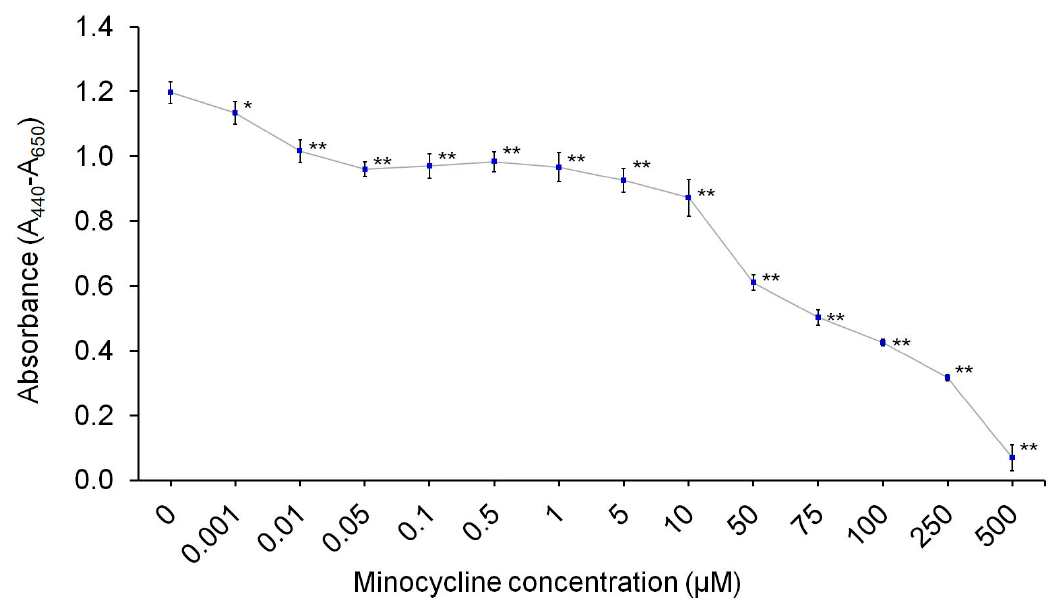
Figure 1. Minocycline inhibits proliferation of human normal melanocytes HEMn-LP cells after 24-h treatment. * p < 0.05 ** p < 0.005.